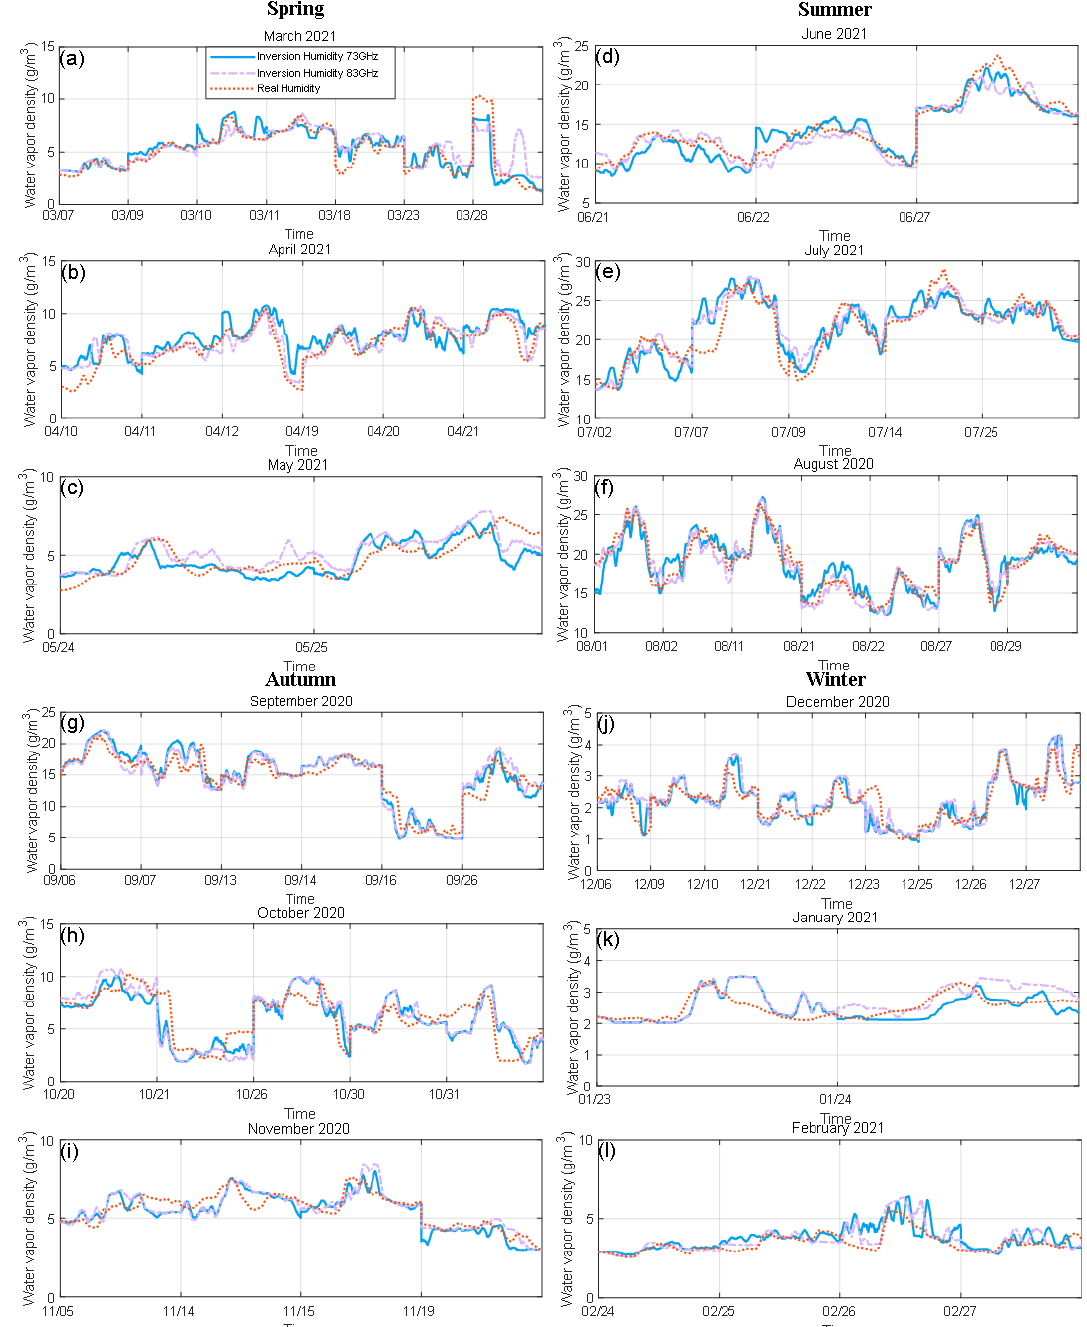
Figure 4. The water vapor density calculated from the data obtained by millimeter wave links on different dates is compared with the measured value of the weather